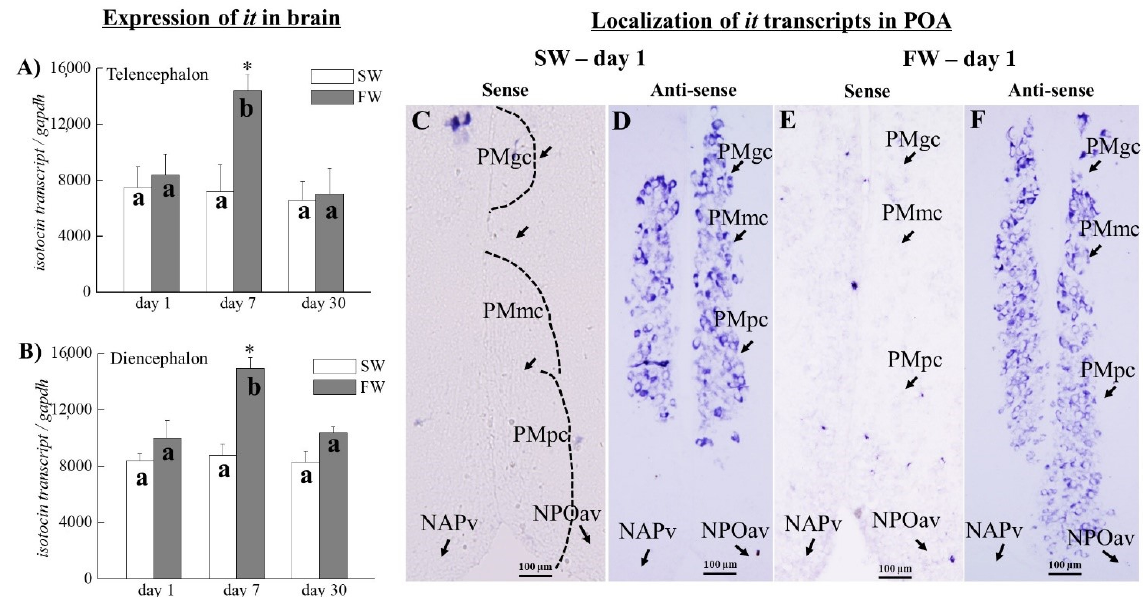
Figure 6. ( A , B ) Q-PCR was performed to analyze the transcripts of it in telencephalon ( A ) and diencephalon ( B ) of SW and FW black porgies on day 1, day 7, and day 30 ( n = 8 in each group). Gene expression was normalized to the control ( gapdh ) gene. The results are expressed as mean ± SEM. Different letters indicate a significant difference between sampling points with the same treatment; asterisks (*) show differences between groups at the same time point (two-way ANOVA followed by Tukey’s test, p < 0.05). ( C – F ) The localization study ( n = 4 in each group) of it transcripts revealed them in the preoptic areas (POAs) of the SW ( D ) and FW ( F ) black porgies on day 1. There were no differences in the it transcripts in PMgc and PMmc, but these increased in PMpc on day 1 of FW ( F ) compared to the SW control ( D ). One of the representative fish from each group is presented for histological data. There were no signals detected in the SW and FW fish when using the it respective control sense probes on day 1 ( C , E ). PMgc: preopticus parvocellularis of pars gigantocellularis; PMmc: preopticus parvocellularis of pars magnocellularis; and PMpc: preopticus parvocellularis of pars parvocellularis. NAPv: nucleus anterioris periventrcularis; and NPOav: anteroventralis nucleus